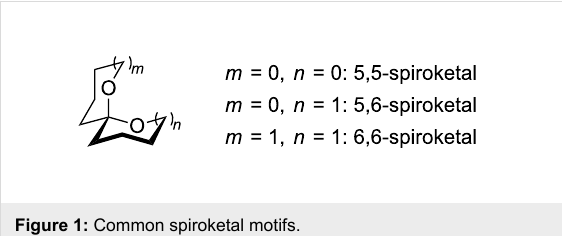
Figure 1: Common spiroketal